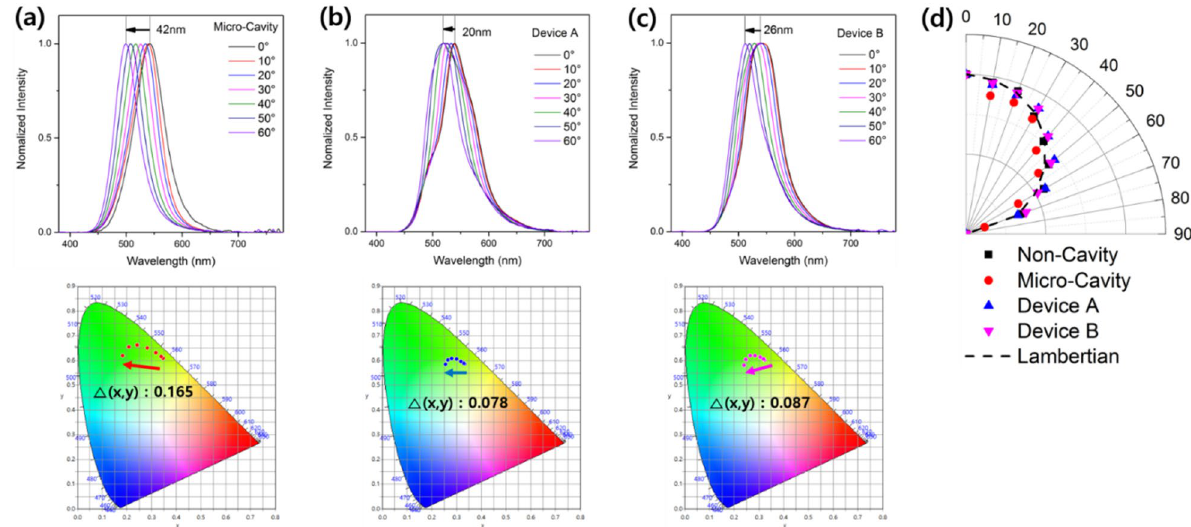
Figure 6. Normalized EL spectra (top) and color coordinates (bottom) showing the shift depending on the viewing angle of the ( a ) Micro-Cavity device, ( b ) Device A, and ( c ) Device B, and ( d ) angular emission pattern of the Non-Cavity device, Micro-Cavity device, Device A, and Device B compared with the Lambertian distribution.